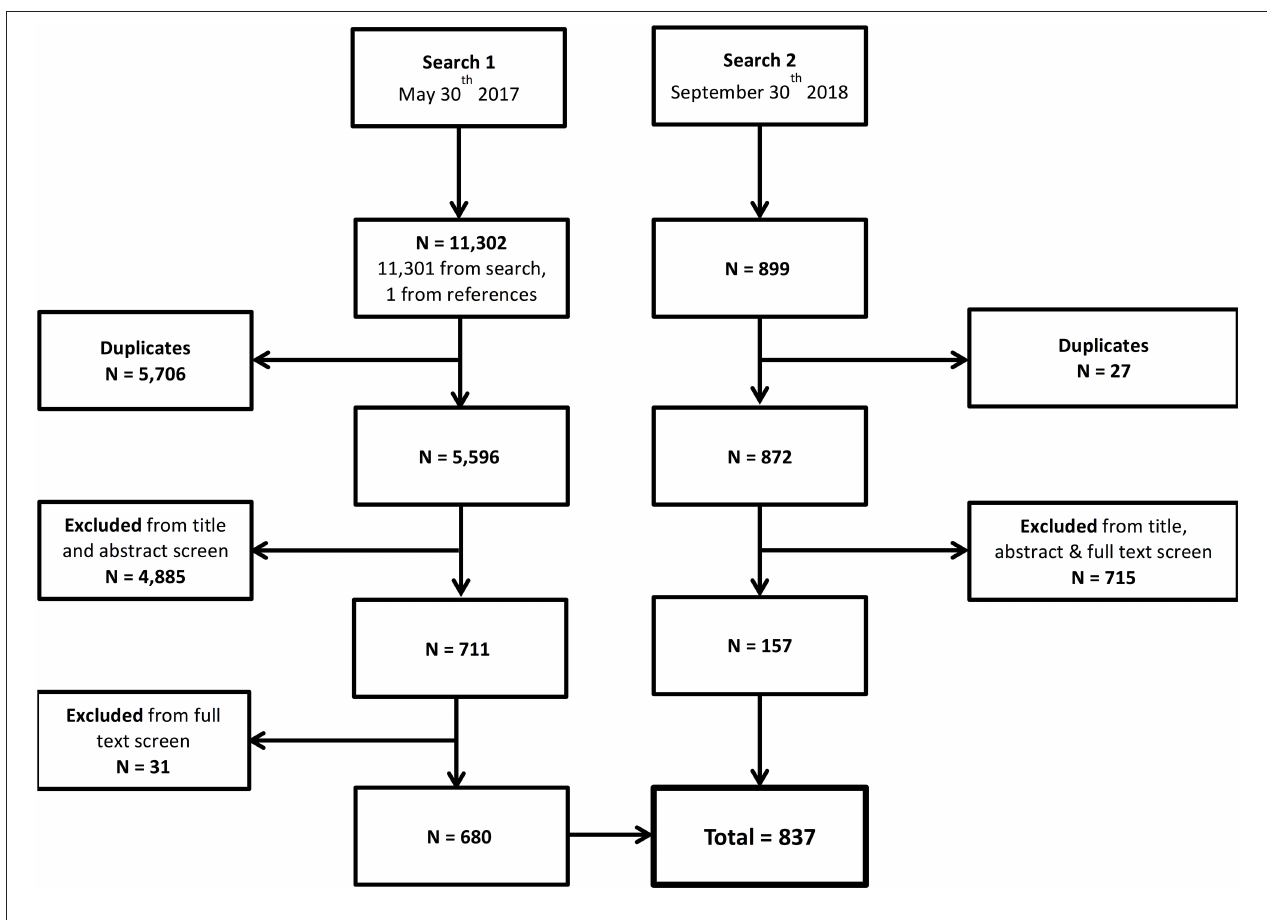
FIGURE 2 | Flow diagram of search results.